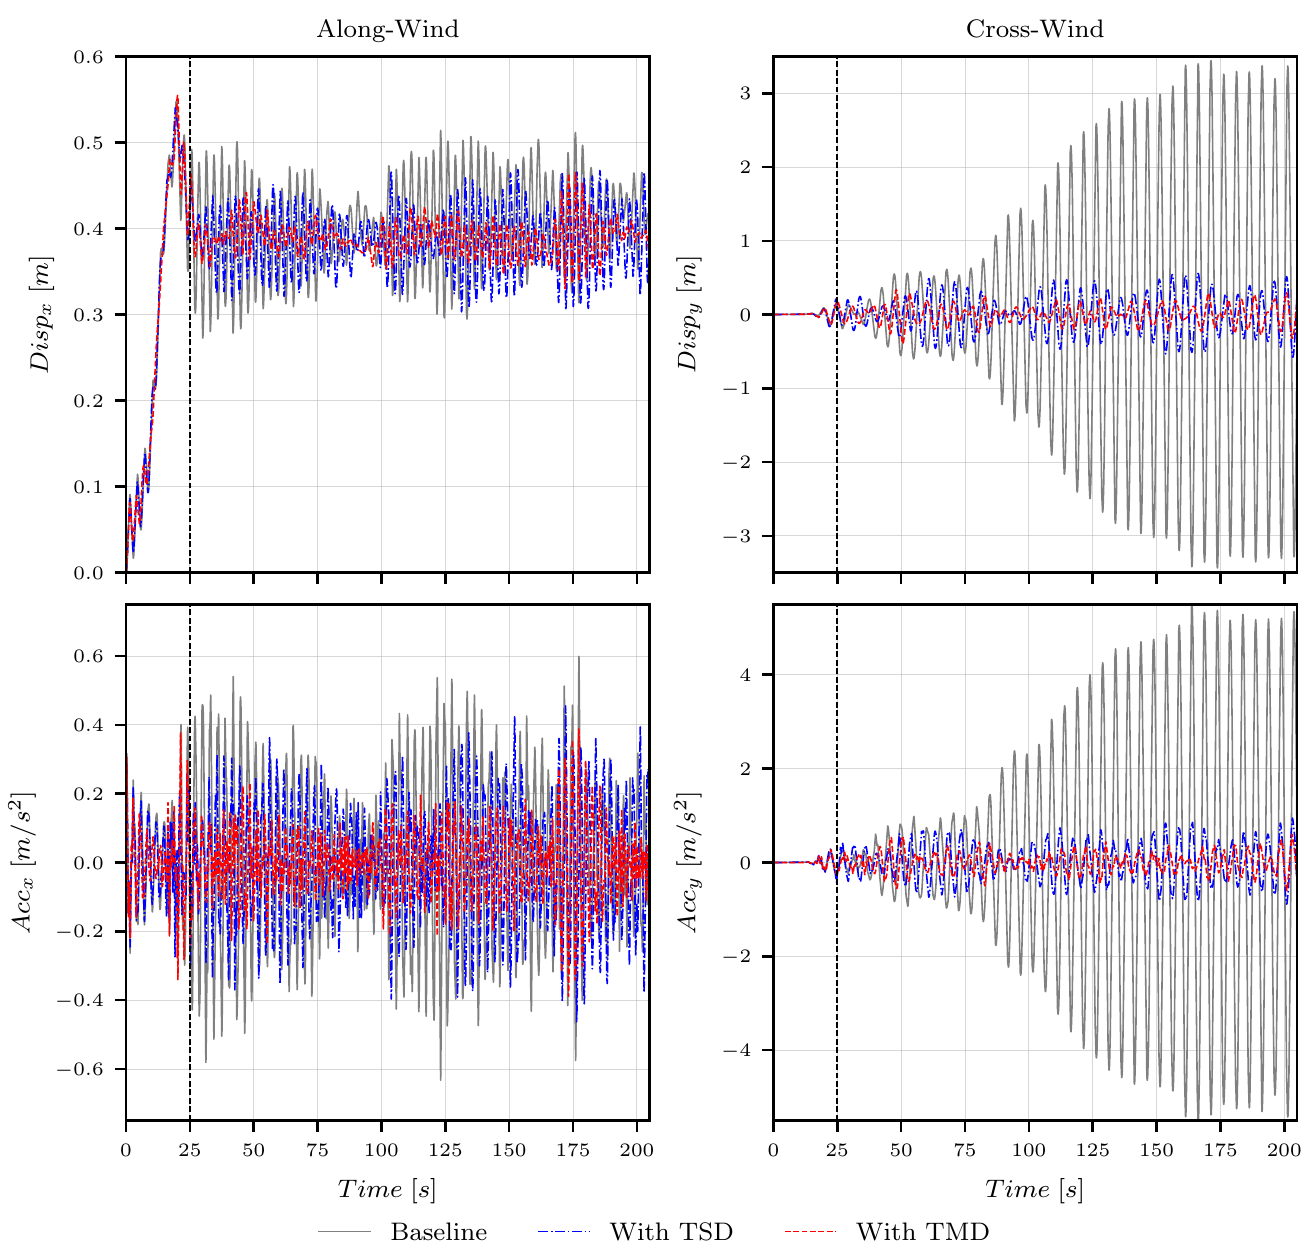
Figure 11. Time series of the kinematics of the top point in smooth flow.